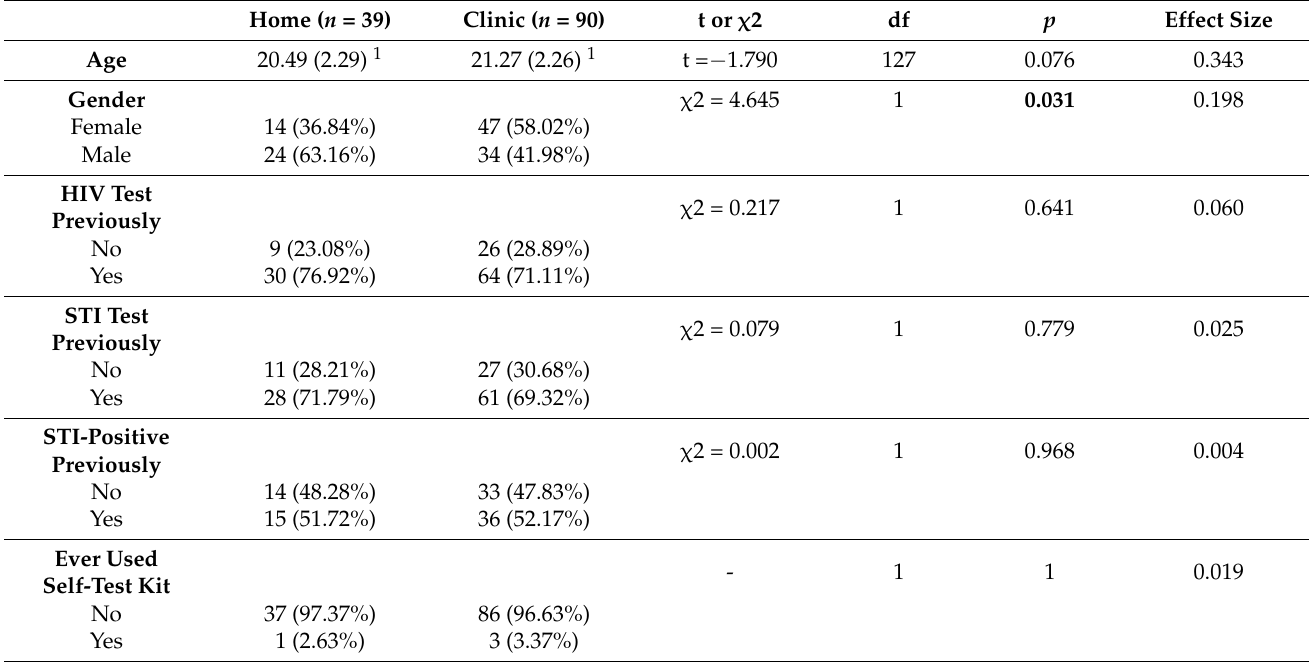
Table 2. Demographics and Preference for Testing Location.